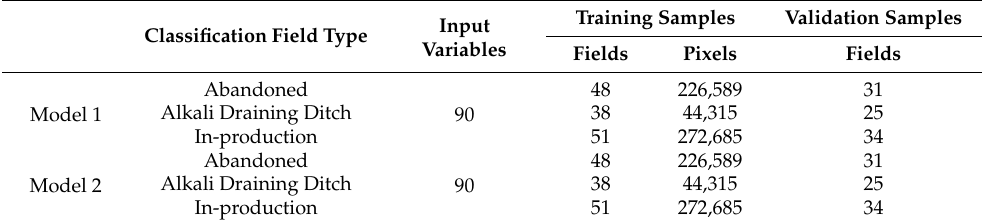
Table 4. Summary of the parameters used in each classification model.